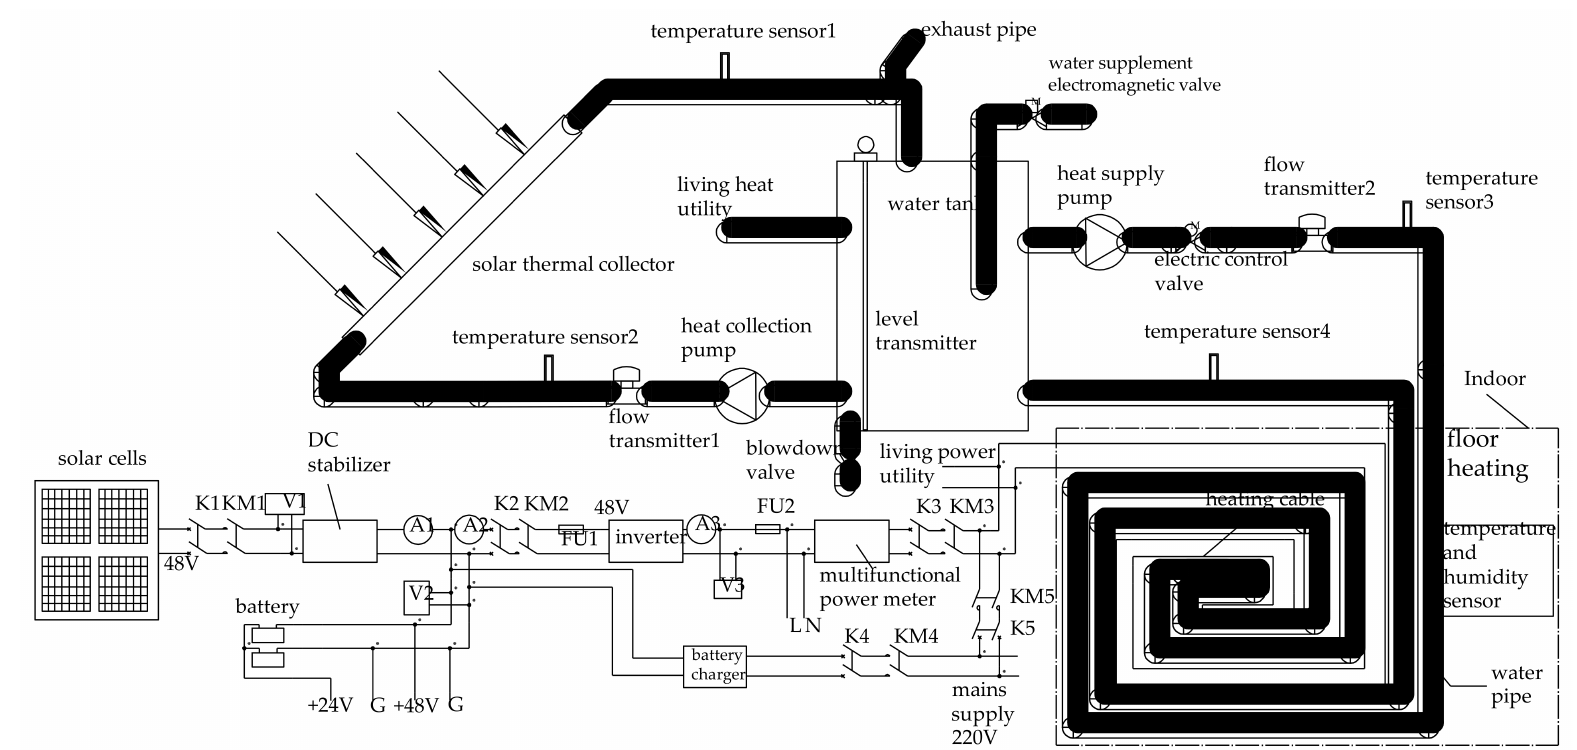
Figure 1. The overall design of the